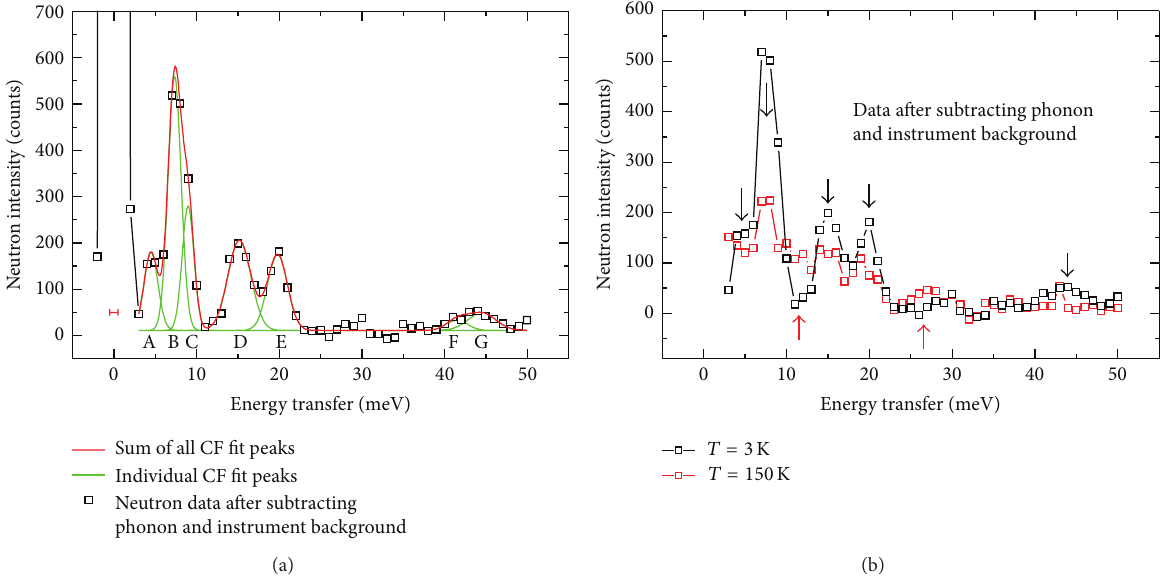
Figure 2: (a) Energy spectra of CF excitations in NdFeAsO 0.85 F 0.15 at 𝑇 = 3 K after subtracting the phonon and instrument background. The spectra were well fitted by seven Gaussian peaks. The instrumental energy resolution is 0.98 meV at elastic position (horizontal bar). (b) ComparisonoftheenergyspectraofCFexcitationsbetween 𝑇 = 3 Kand 𝑇 = 150 Kaftersubtractingthephononandinstrumentbackground. The black lines are guides to the eye.